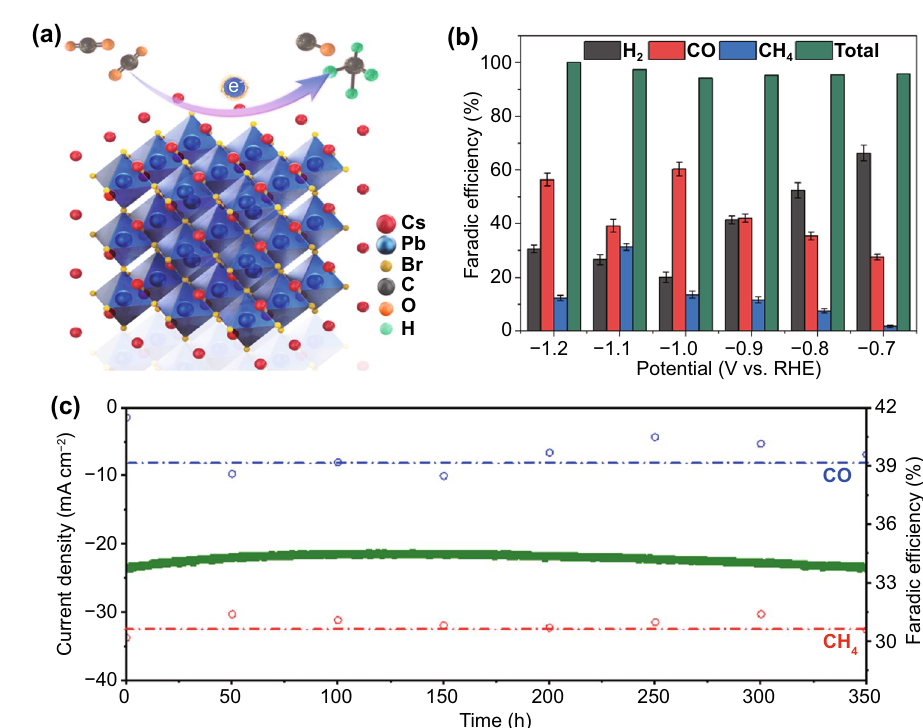
Fig. 5 a Schematic of the w‑CsPbBr 3 NCs CO 2 RR; b Faradic efficiencies for the w‑CsPbBr 3 NCs CO 2 RR; c chronopotentiometry curve (long‑ term stability) of